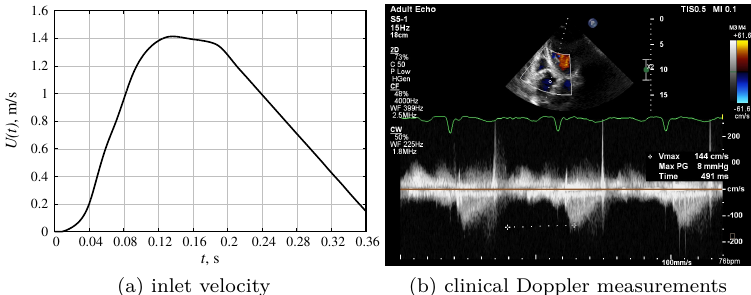
Figure 2. The analytic approximation a) of the measured blood velocity b) serving as the inlet boundary condition